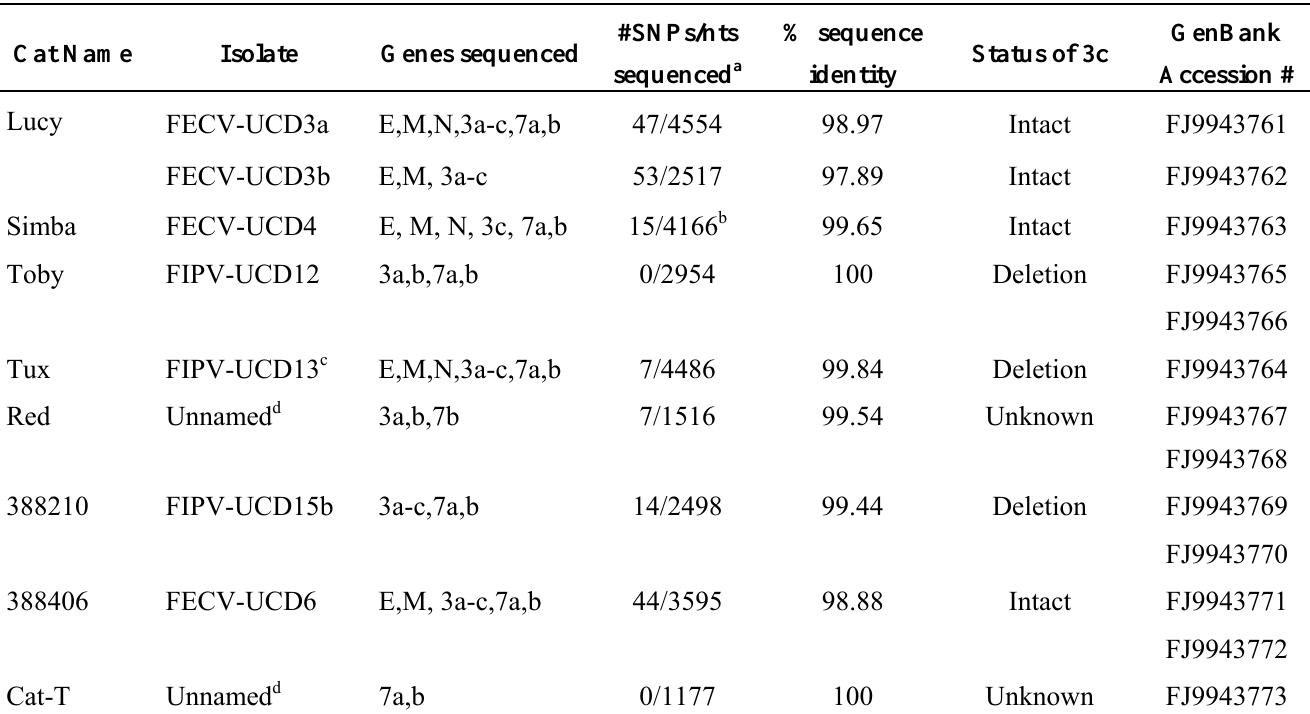
Table 3. Name and biotype designation of coronavirus isolates (including variants) from the feces of eight cats dying of FIP. The genes that were sequenced, their mutability, degree of relatedness to lesional isolates, and the nature of the functional mutation in the 3c gene are given for each